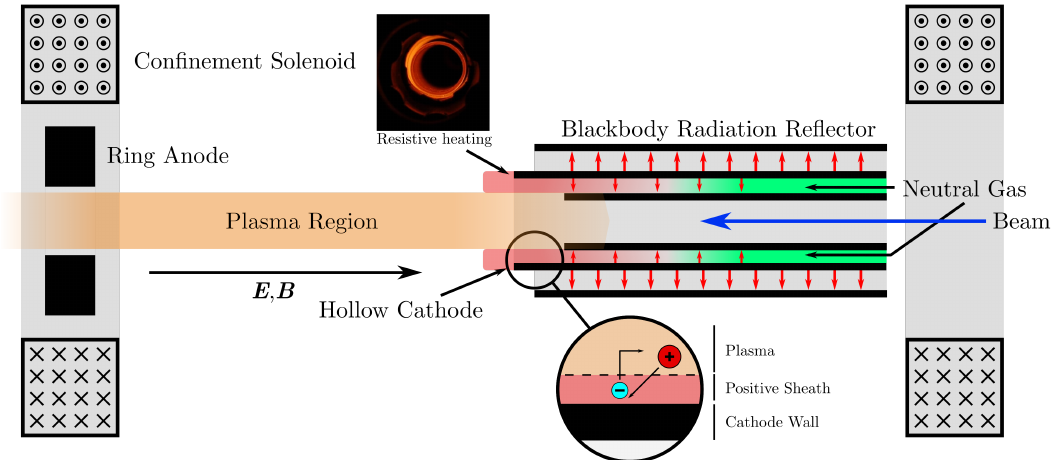
Figure 1. Cross section of the hollow cathode arc plasma source showing active regions of the